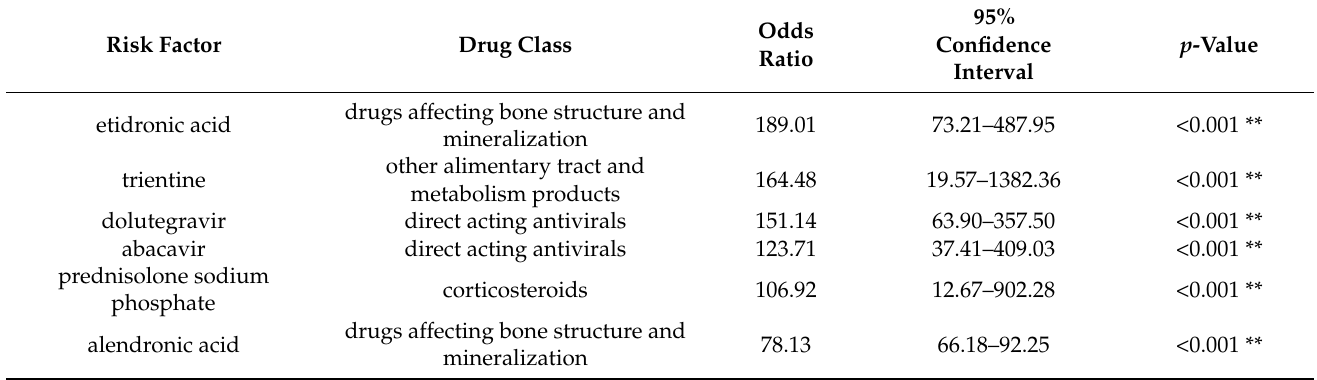
Figure 2. Drugs associated with drug-induced fracture. The X-axis shows the natural logarithm of the odds ratios (ln ([OR]), and the Y-axis shows the common logarithm of the inverse p -value ( − log10 [p]) from Fisher’s exact test. The ORs were calculated using cross-tabulation. The dotted line on the Y-axis represents p = 0.05. Plot colors represent the number of reports of adverse events. The red-green-blue points are common logarithms of the total reported numbers (range, − 0.20 to 4.35). As the ORs become more positive, the tendency toward adverse events increases; decreasing p -values indicates greater statistical significance. The upper-right portion of the scatter plot identifies drugs that more highly associated with drug-induced fracture. Table 3. Multiple logistic regression analysis of fracture risk according to drug use and patient characteristics ( n =